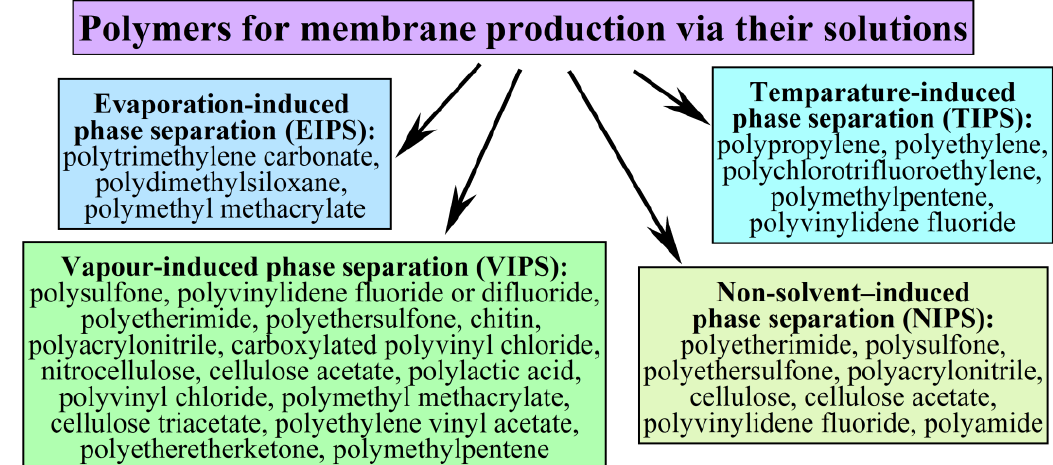
Figure 1. Methods for obtaining membranes from polymer solutions and the polymers used.